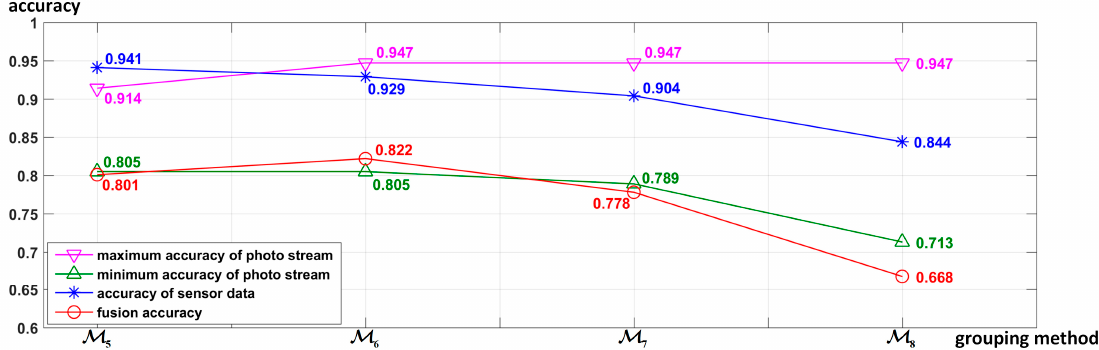
Figure 23. Accuracy comparison of different grouping methods shown in Table 4 used in the proposed hierarchical deep fusion framework.